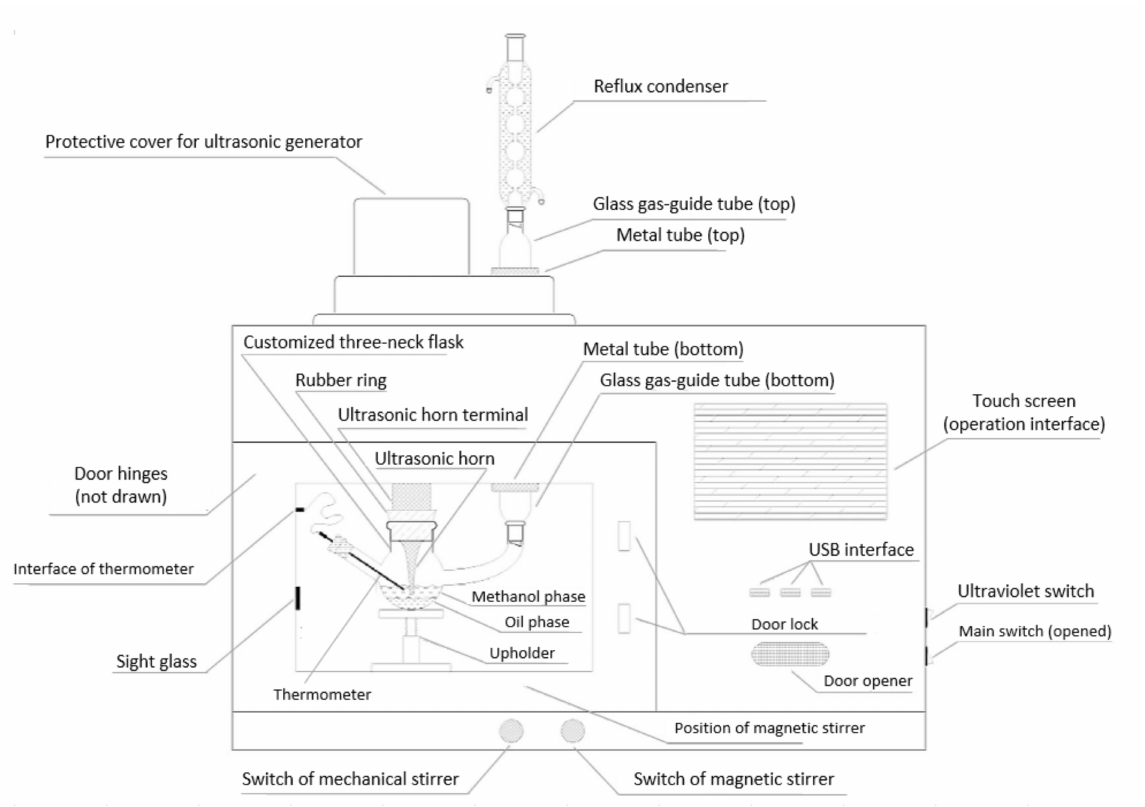
Figure 2. Synergistic microwave-ultrasonic reactor for transesterification of soybean oil with methanol. Reproduced with permission from Ultrason. Sonochem . 2017 , 281–290. Copyright (2017) Elsevier